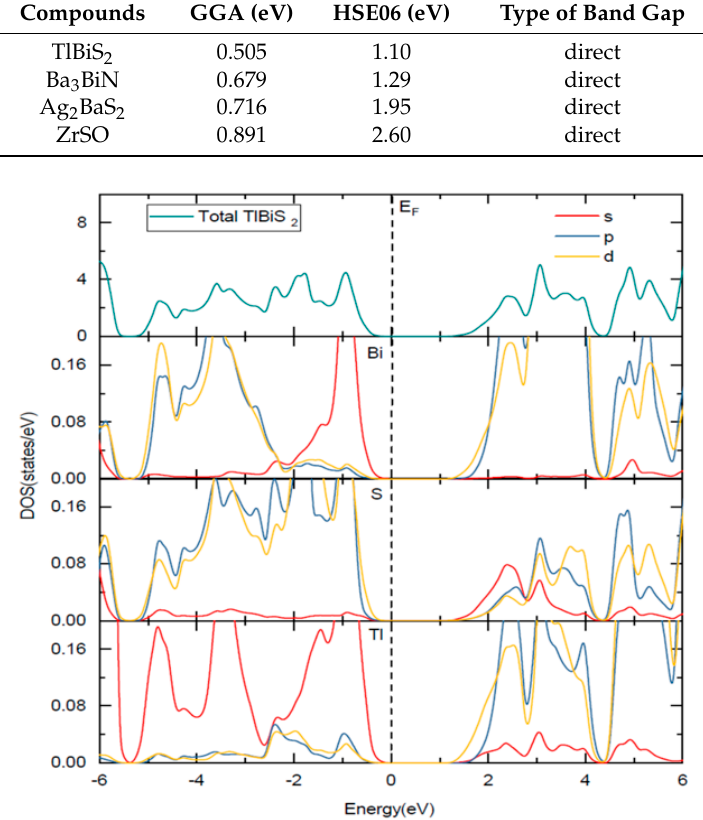
Figure 3. Total and site projected density of states of TlBiS 2 . The Fermi level is set to zero. The Fermi level is set to zero and marked by a vertical dotted line.